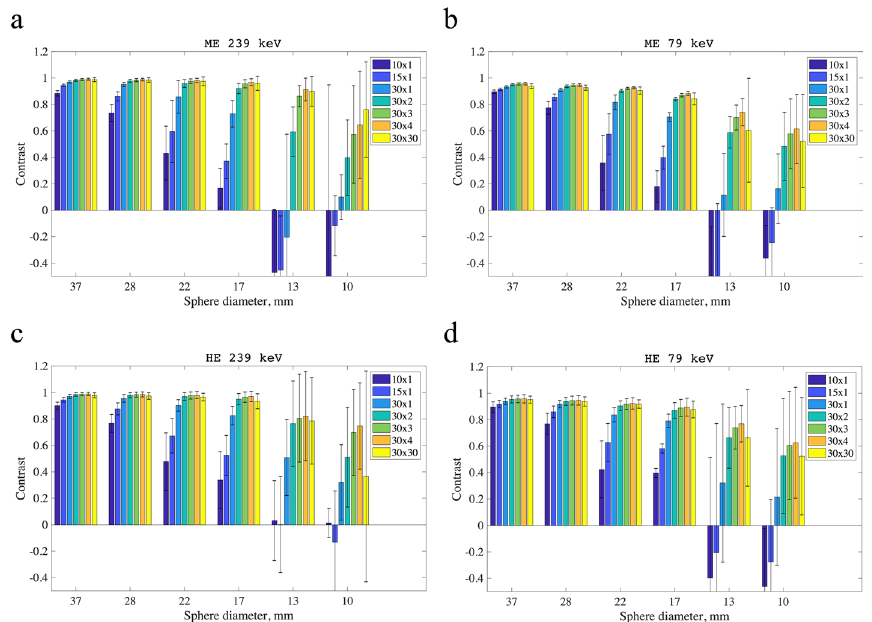
Fig. 9 Contrast plotted against sphere diameter for all the image protocols for the different reconstructions with a 12‑mm Gaussian filter. Contrast was calculated with Eq. 4, except for when the source VOI included no counts. In cases with no counts in the source VOI, contrast was set to 0 to find averages and SDs. The equivalent plots based on unfiltered images can be found in the supplementary material. The ME 239 keV results are shown in panel a , the ME 79 keV results are shown in panel b , the HE 239 keV results are shown in panel c , and the HE 79 keV results are shown in panel